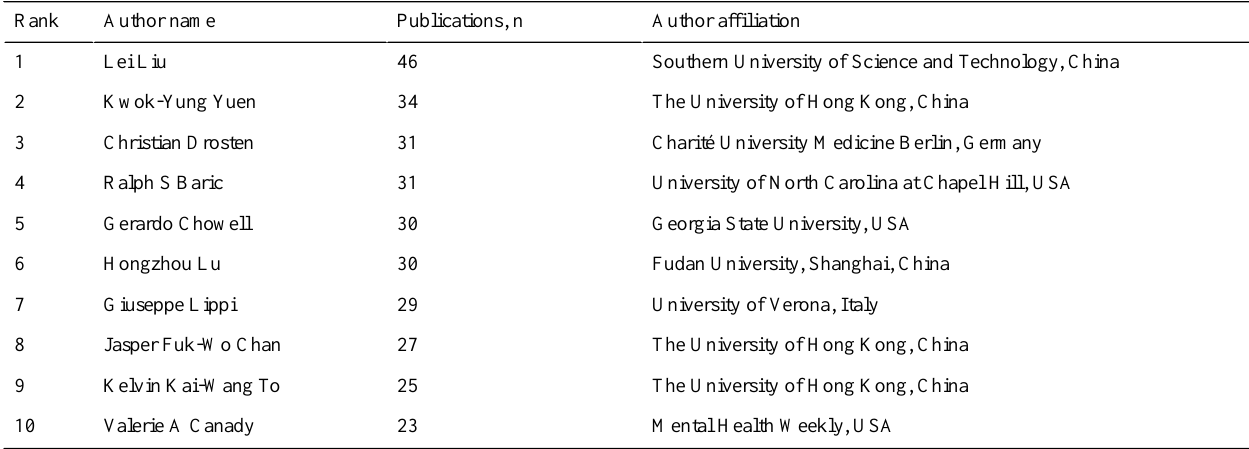
Table 3. Top 10 authors (N=15,600) by the number of COVID-19–related publications.